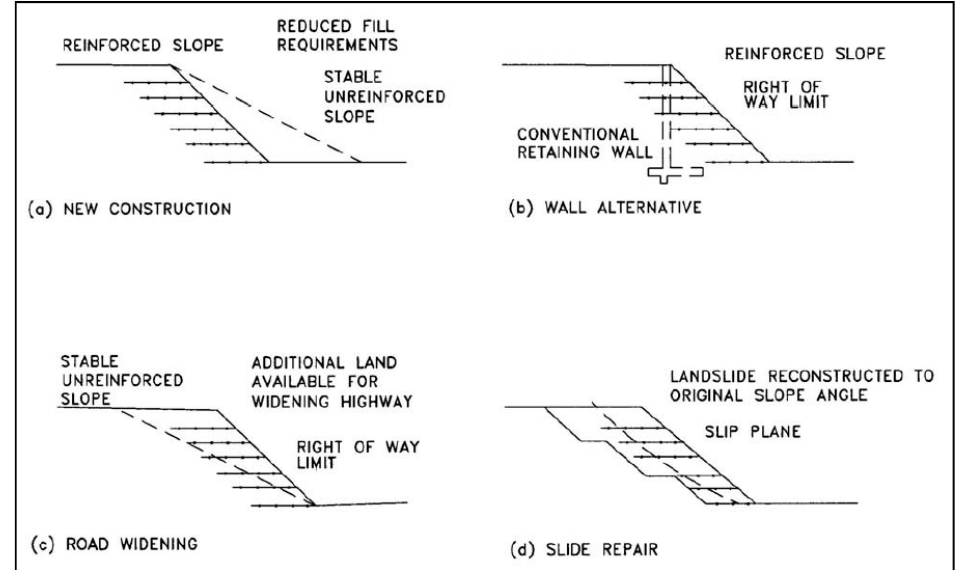
Figure 1. Geosynthetic Reinforced Steep Slope Applications [10].